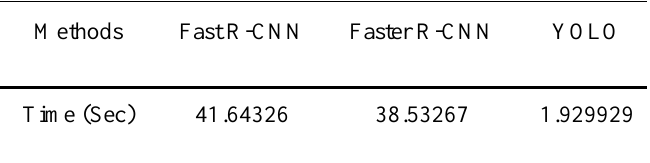
Table 3. Comparative analysis based on